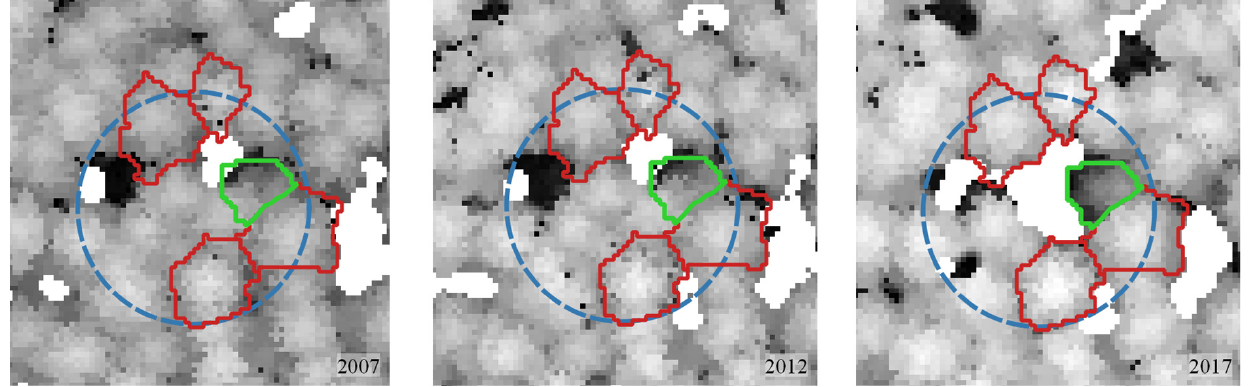
Figure 8. Example of a circular sample plot (blue, dashed outline) over time. Consequence of removing a tree obscuring the crown of a lower tree (green outline) between 2012 and 2017 on the calculation of increments within reference segments. Measurement of the tree height of the other neighboring Scot Pine trees (red outline) were not influenced by this process.